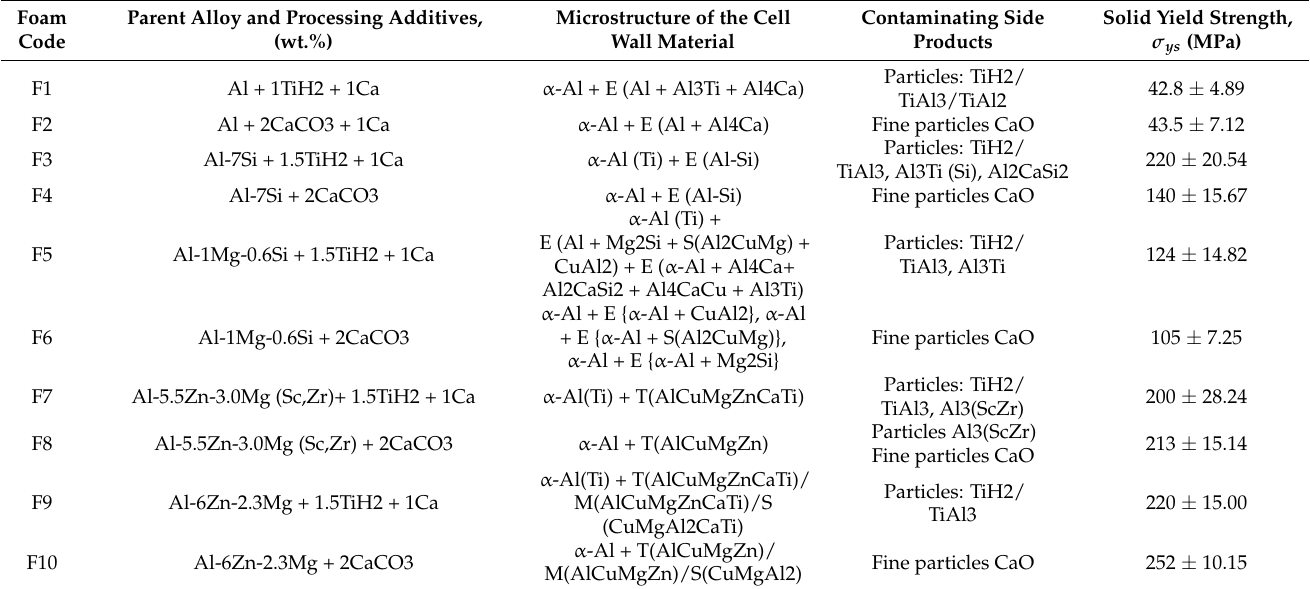
Table 1. Specification of the aluminum foams created via melt